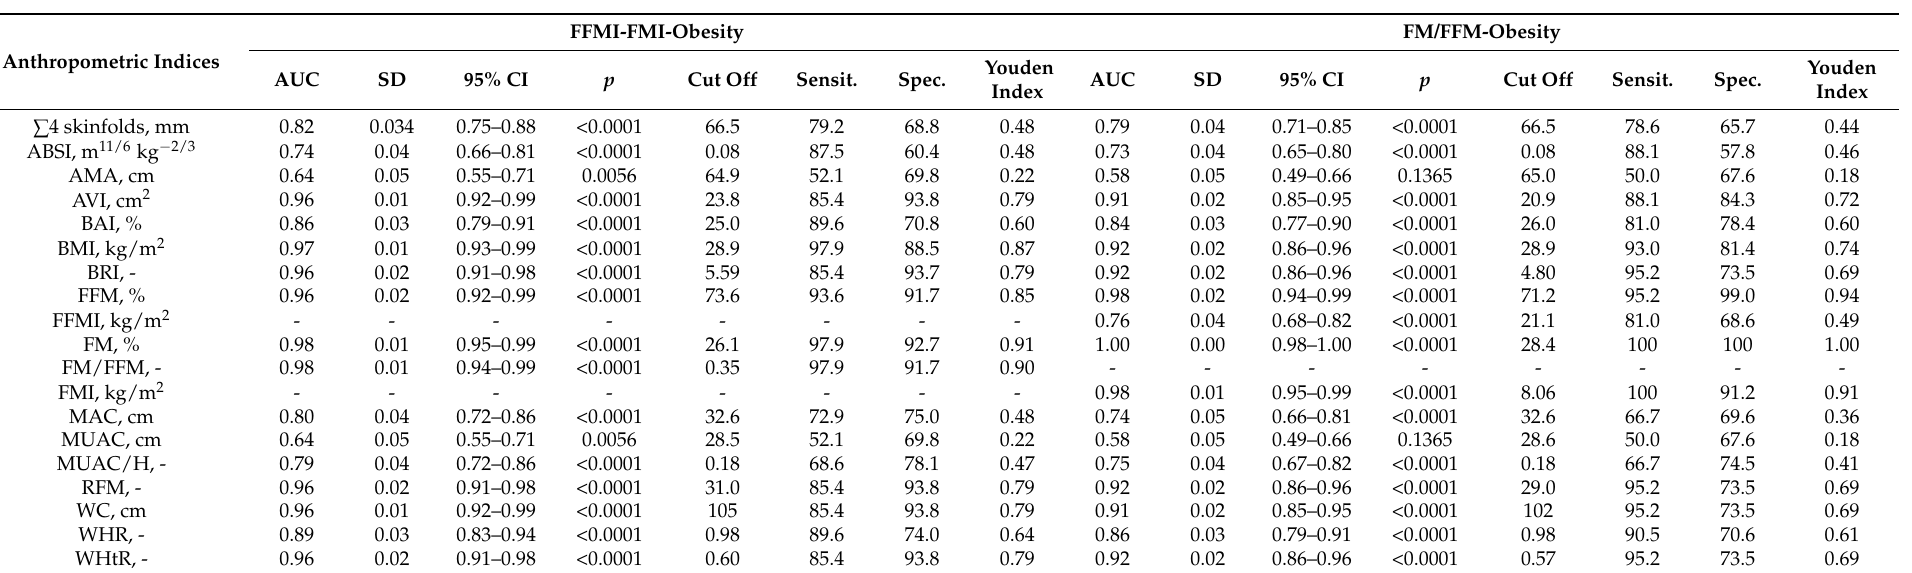
Table 5. The area under ROC curve (AUC), optimal cut-off values, sensitivity (Sens.), specificities (Spec.), and Youden index of anthropometric indices in predicting obesity by using FMI-FFMI or FM to FFM ratio in